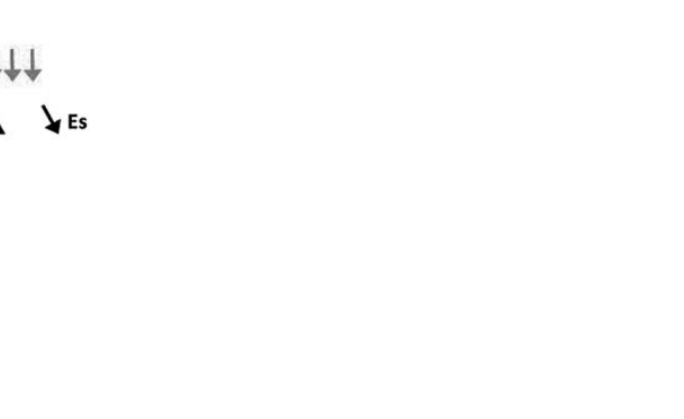
Figure 2. Monthly SMAP, schematic diagram of operation. The arrows in the figures indicate the flow direction (streamflow and evaporation) and the triangle indicates the division of the outflow after precipitation. Source: [17].